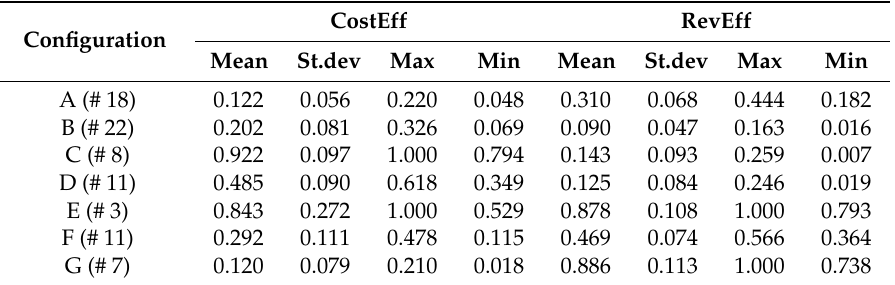
Table 5. Statistics of clustering variables relative to pipeline infrastructure configurations.